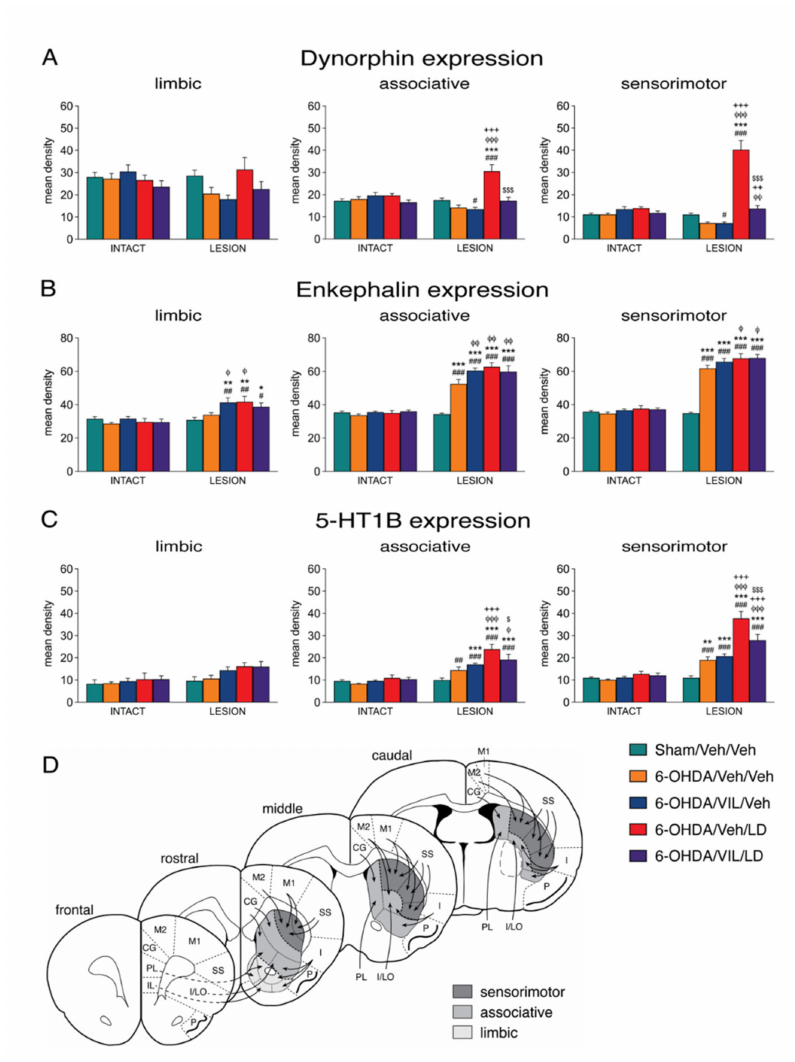
Figure 5. Summary of effects on striatal gene regulation in pooled limbic, associative, and sensorimotor sectors. Mean density values (mean ± SEM) for dynorphin ( A ), enkephalin ( B ), and 5-HT1B expression ( C